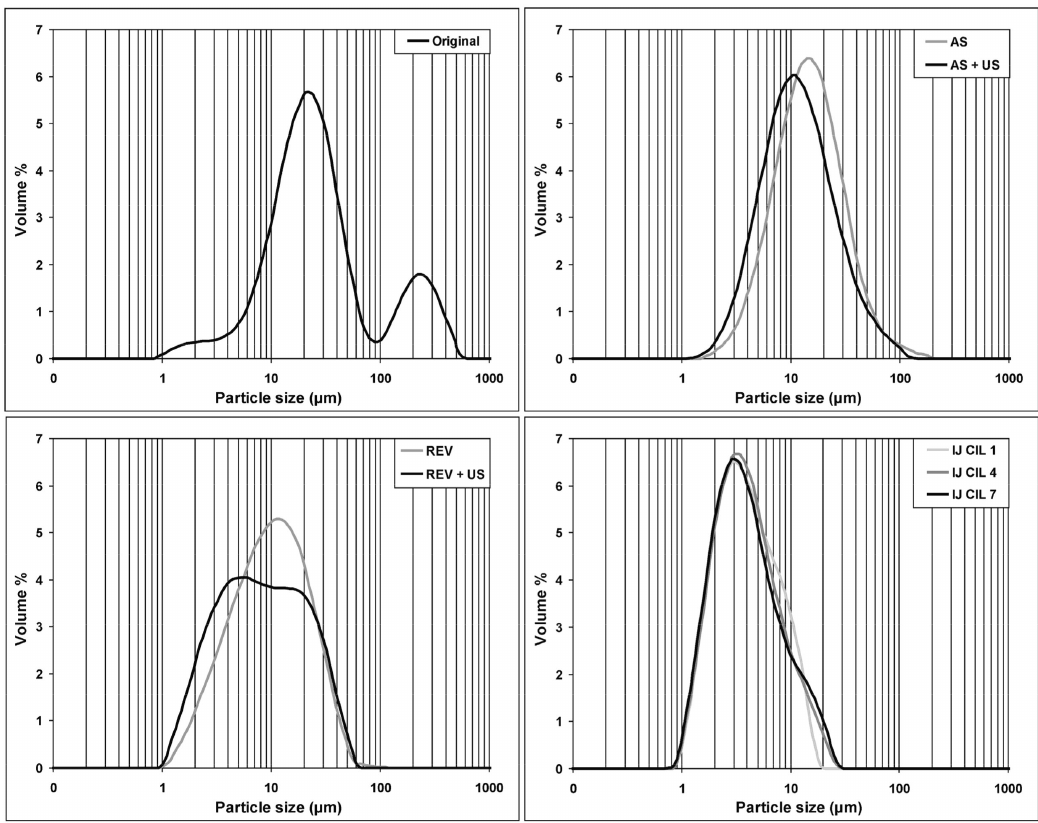
Figure 3. Comparison of particle size distributions of samples made with di ff erent crystallization methods.